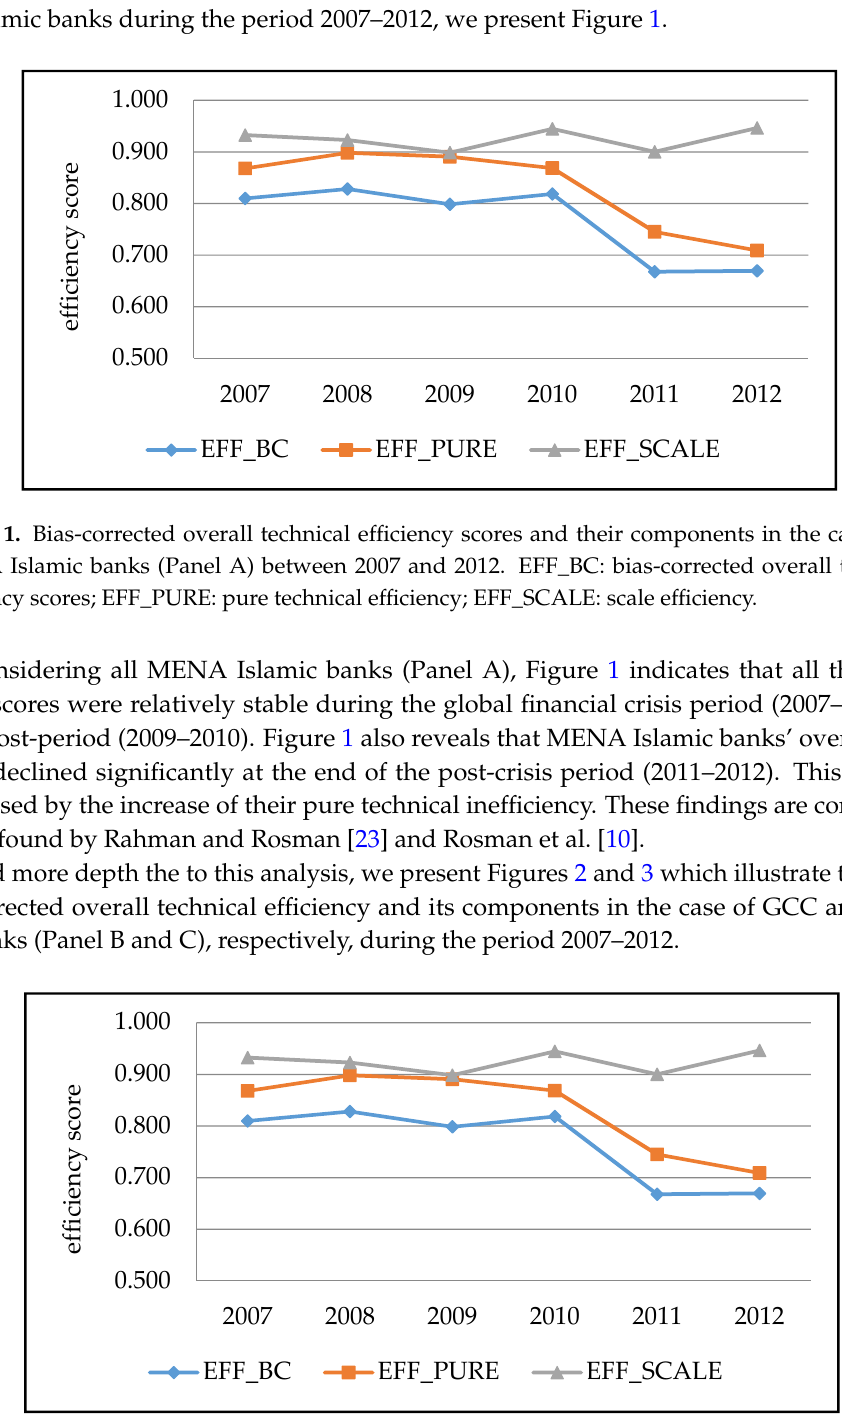
Figure 2. Bias-corrected overall technical efficiency scores and their components in the case of GCC Islamic banks (Panel B) during the period